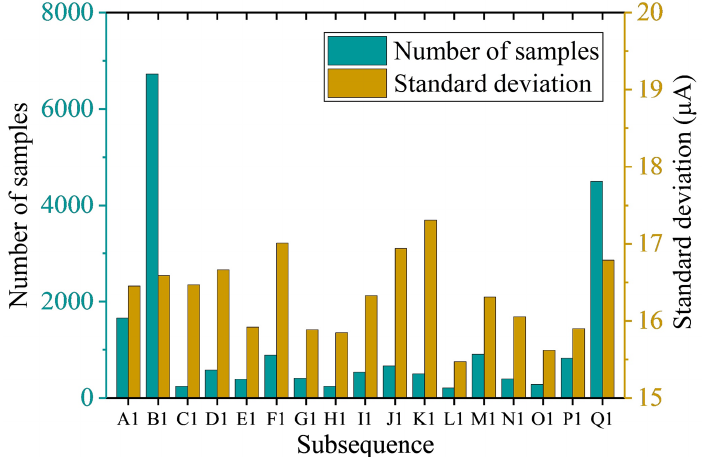
Figure 6. Number of samples and standard deviation of each subsequence segmented by the signal 1.